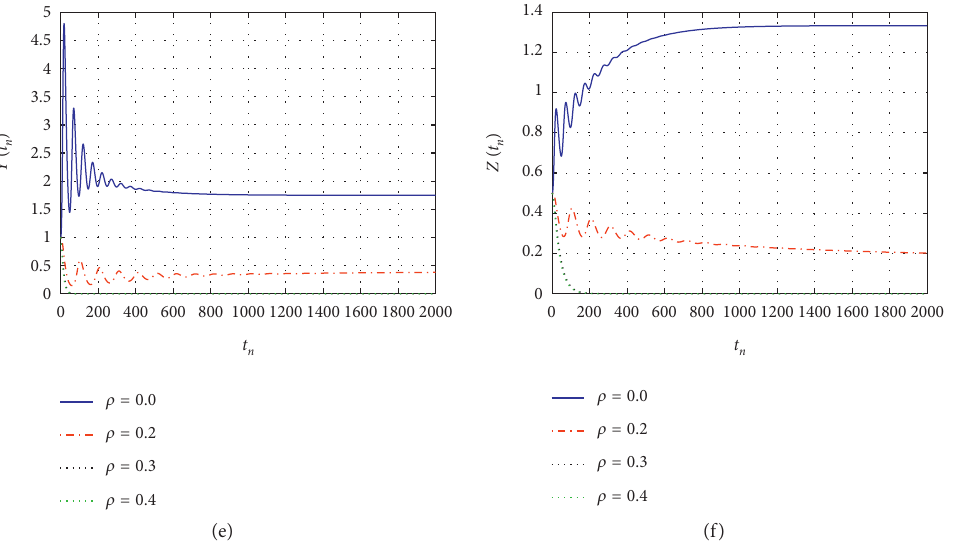
Figure 6: The solutions of systems (12)–(17) with different values of ρ .